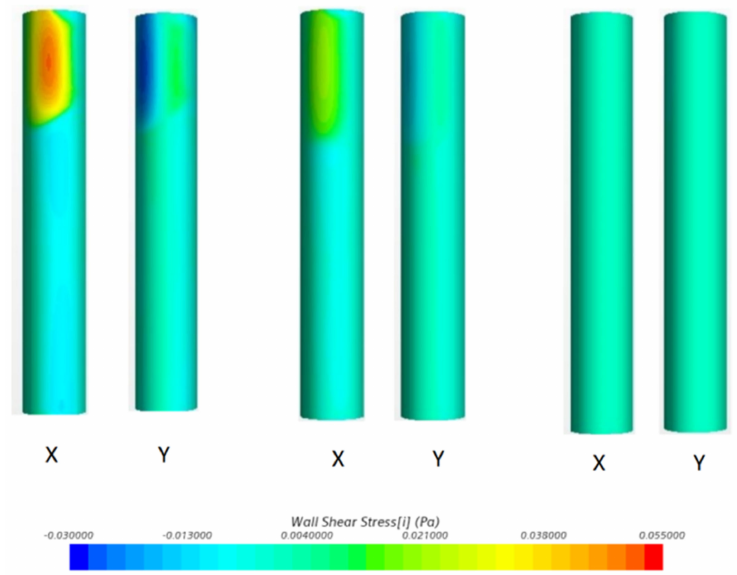
Figure 17. Contrast diagram of wall shear force in x and y directions of the riser ( t = 30 s). From left to right: working condition 1, working condition 3 and working condition